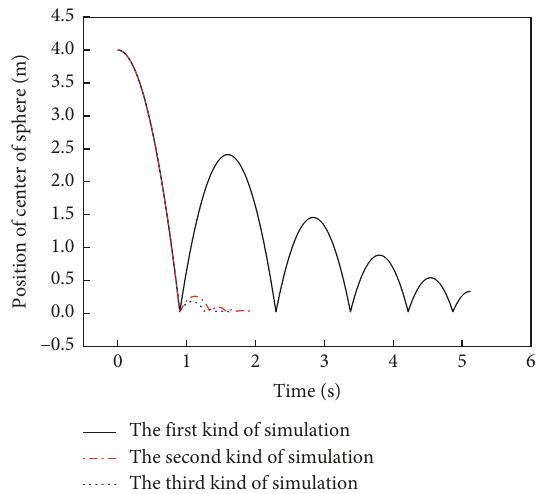
Figure 13: Acceleration of centroid